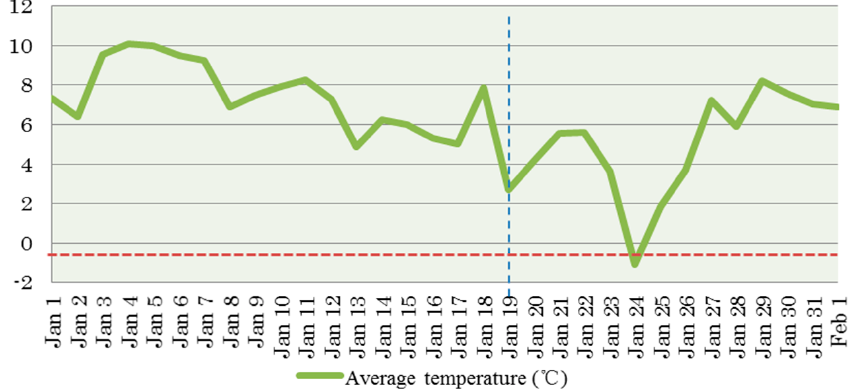
Figure 7. Average daily temperature of the pre-experimental and experimental periods in the winter 2016. Source: Japan Meteorological Agency, Climate Statistics [19].